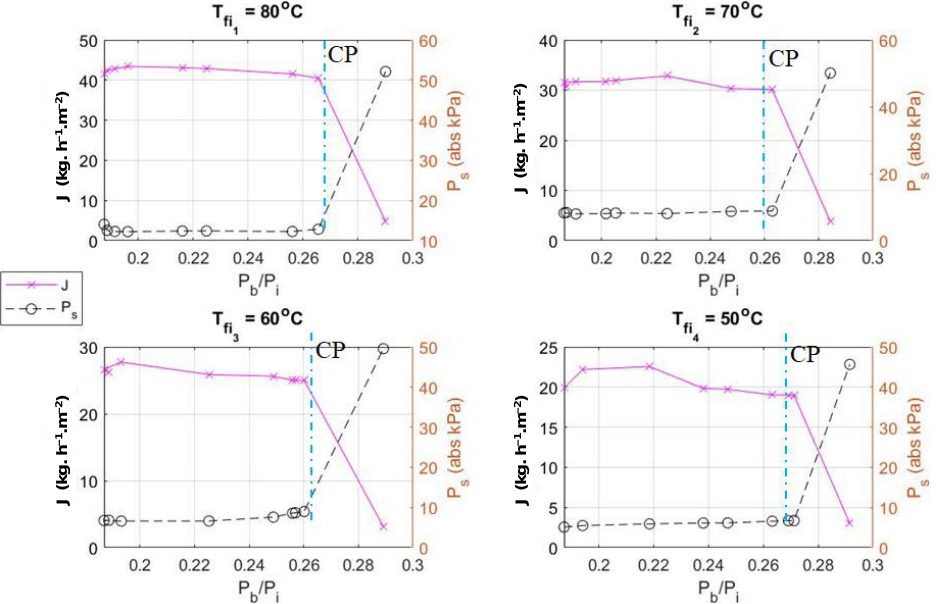
Figure 8. Mass flux (J) with respect to P b /P i at different T fi (cold side temperature constant at T p = 15 °C).